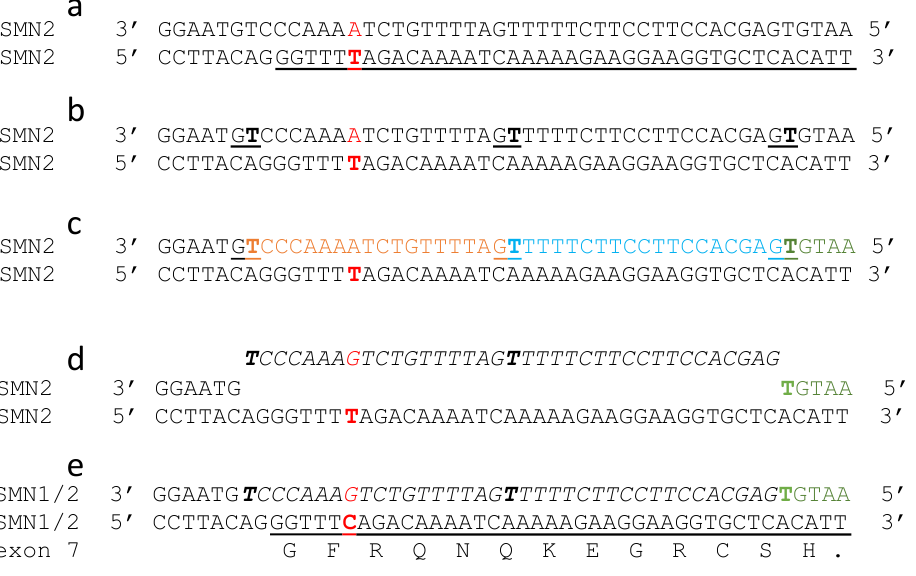
Figure 8. A theoretical correction, by three camptothecin based PIP-OTIs, of the exon 7 mutation associated with SMA. ( a ) DNA sequence from human SMN2 gene (NCBI’s RefSeq gene ID: 6607). Experimental evidence suggests that Exon 7 (underlined sequence–bottom line) is skipped because of alternative splicing due to a single base change (AT base-pair highlighted in red). ( b ) Three positions (TG) positions (5 (cid:48) –3 (cid:48) ) on the upper, non-coding strand, to be targeted for cleavage by PIP-OTIs are underlined (note upper strand is drawn 3 (cid:48) –5 (cid:48) ). ( c ) In the presence of Top1 (see also Supplementary Figures S3 and S5) three PIP-OTIs are predicted to cleave the DNA at three positions and remain covalently linked to the T’s. ( d ) After removal of the PIP-OTIs and covalently attached DNA–a gene editing oligonucleotide with a corrected G is introduced. ( e ) After the ‘theoretical’ correction of the G-T (in panel d ) mismatch to G-C (panel e ) exon 7 should be expressed (as in SMN1 ).